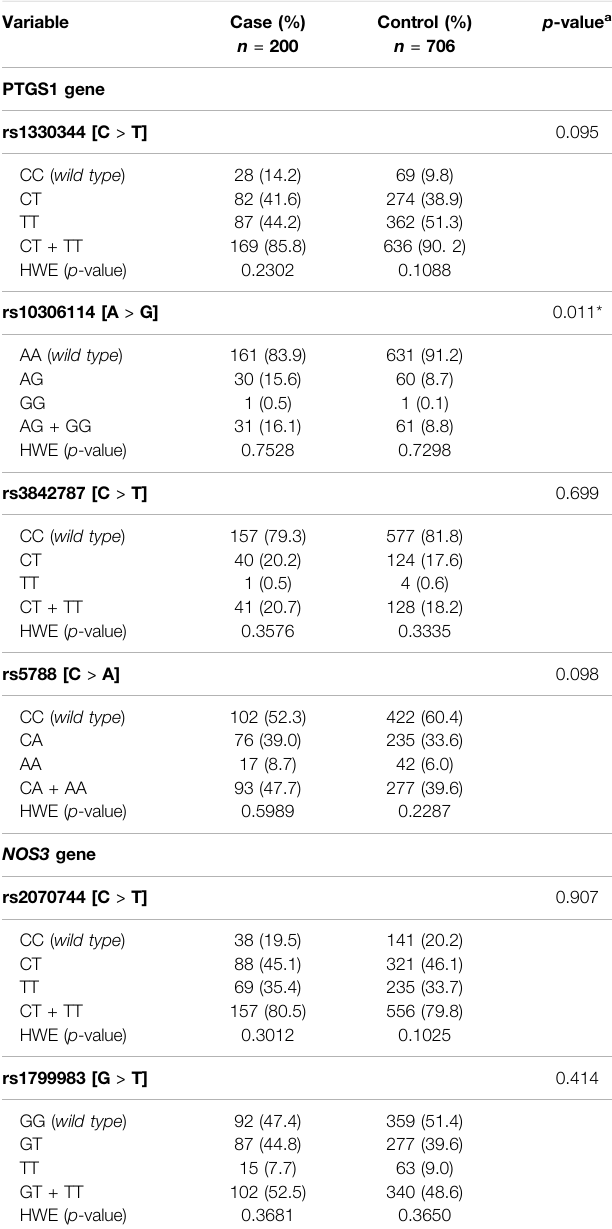
TABLE2| Descriptionoffrequencyofgeneticvariantsin PTGS1 and NOS3 genes between the case and control groups and Hardy – Weinberg equilibrium.